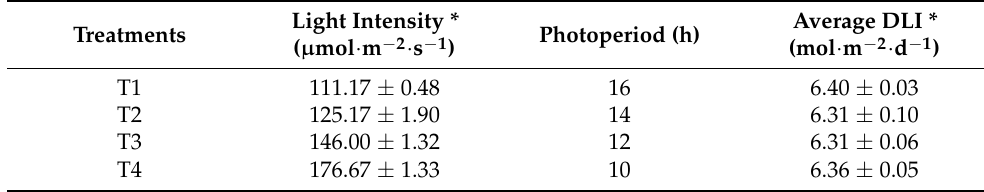
Table 2. Four combinations with different light intensities and photoperiods that achieve the same DLI in Exp.